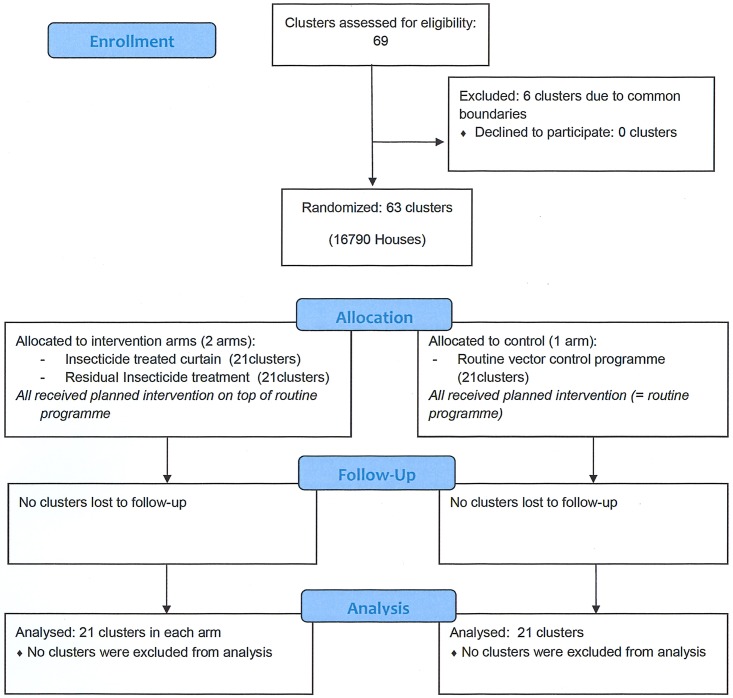
CONSORT flowchart.